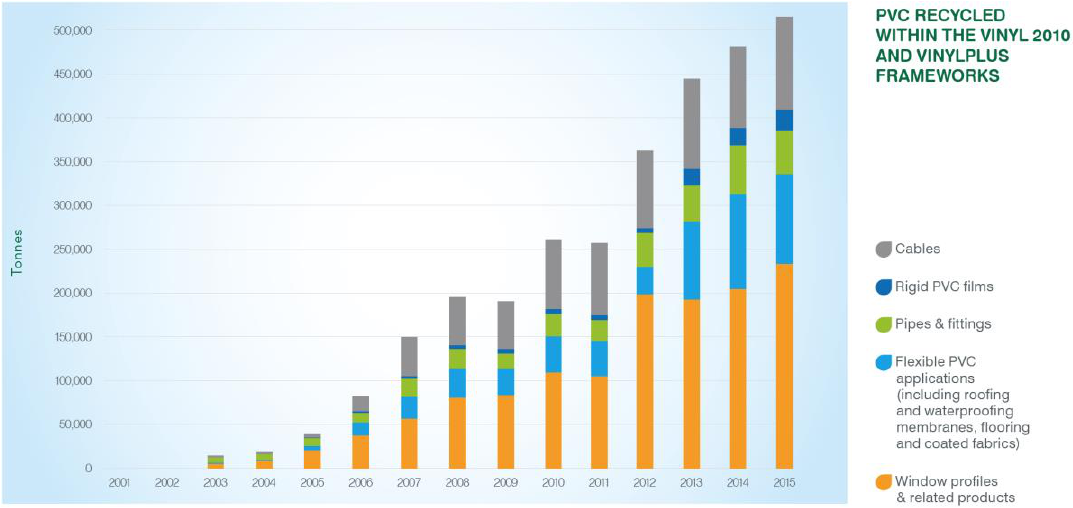
Figure 4. PVC recycled within the Vinyl 2010 and VinylPus frameworks [92], in tonnes (=Mg).